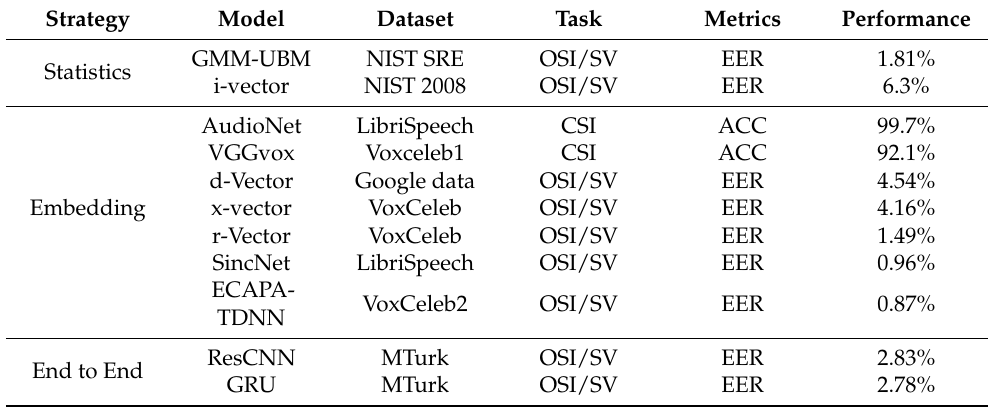
Table 1. Common victim SR models.